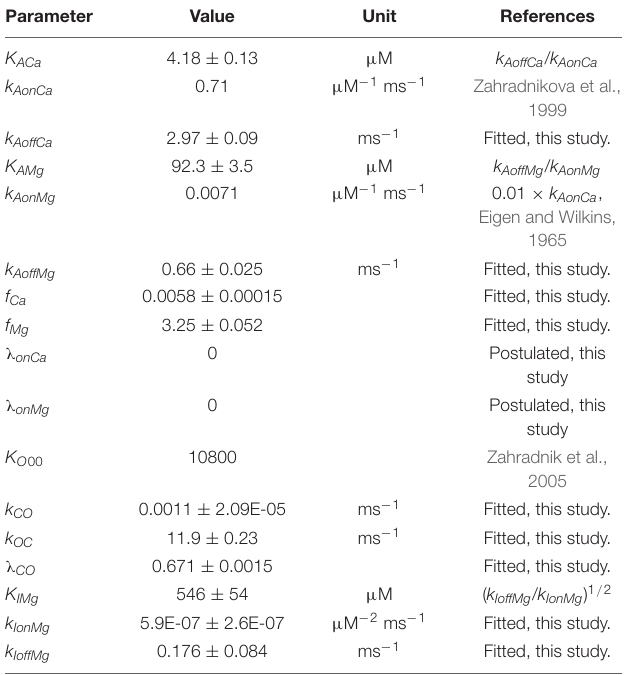
TABLE 1 | Parameters of the ryanodine receptor (RyR) model and their reference values. Parameter Value